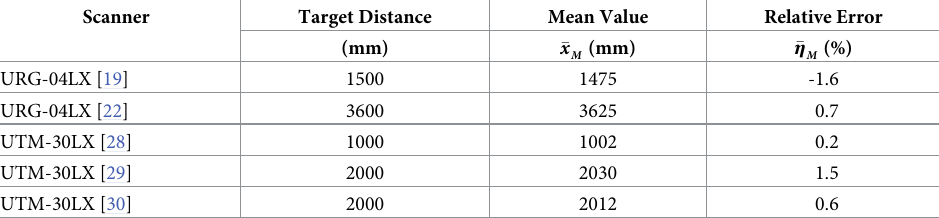
Table 3. Comparison of drift effects.